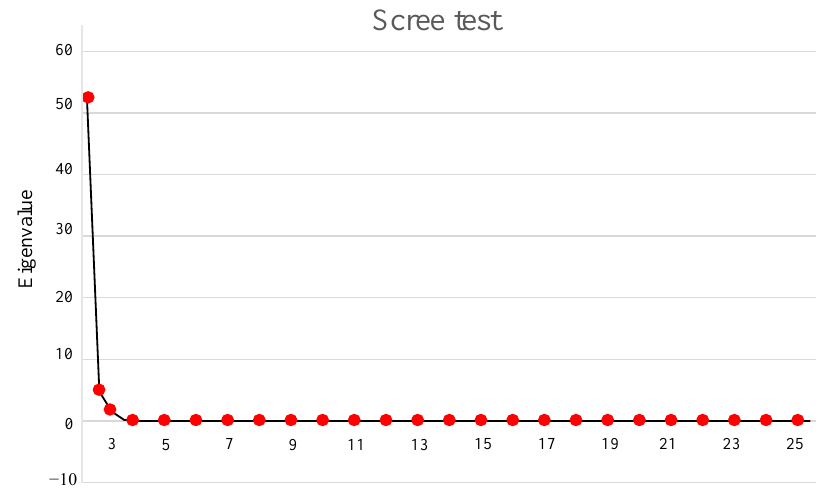
Figure 3. Scree test of the three scenarios in the experiment. Figure 4a presents a 3D PCA figure of the data from the experiment, where the experimental data for the three situations is obviously split into three groups. Additionally, Figure 4b shows a 2D plot of the XY surface, and Table 3 shows some of the partial PC band weights.